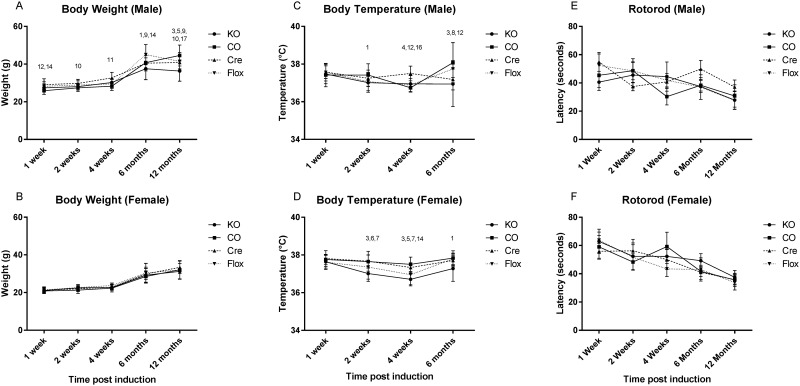
General phenotyping for Adrb2flox GLAST-CreERT2 double mutants.Genotype groups used were: Adrb2flox +/+ GLAST-CreERT2+/- animals treated with tamoxifen (KO) or the corn oil vehicle (CO), tamoxifen treated conditional Cre expressing mice (CRE) (Adrb2flox -/-GLAST-CreERT2+/-) and tamoxifen treated floxed mice (FLX) (Adrb2flox +/+GLAST-CreERT2-/-). The body weight of (A and B), body temperature (C ad D), and latency to fall on the RotaRod (E and F) is shown at time points after the tamoxifen treatment. Rotorod data is shown as the mean +/- SEM, other measure are mean +/- SD. Significance: 1 KO+ vs CO p<0.05, 2 KO+ vs CO p<0.01, 3 KO+ vs CO p<0.001, 4 KO+ vs CRE p<0.05, 5 KO+ vs CRE<0.01, 6 KO+ vs CRE p<0.001, 7 KO vs FLX p<0.05, 8 KO vs FLX <0.01, 9 KO vs FLX p<0.001, 10 CO vs CRE p<0.05, 11 CO vs CRE<0.01, 12 CO vs CRE p<0.001, 13 CO vs FLX p<0.05, 14 CO vs FLX<0.01, 15 CO vs FLX p<0.001, 16 CRE vs FLX p<0.05, 17 CRE vs FLX<0.01, 18 CRE vs FLX p<0.001.